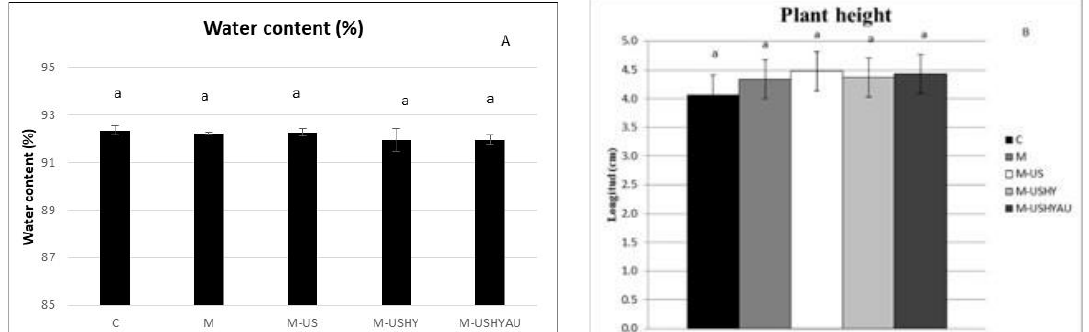
Figure 5. Water content (%) ( A ) and plant height (cm) ( B ). Data are means ± standard error. Values followed by different letters are significantly different ( p ˂ 0.05). The values are the means of data followed by different letters are significantly different ( p < 0.05). The values are the means of data from 12 plants for each replicate. from 12 plants for each